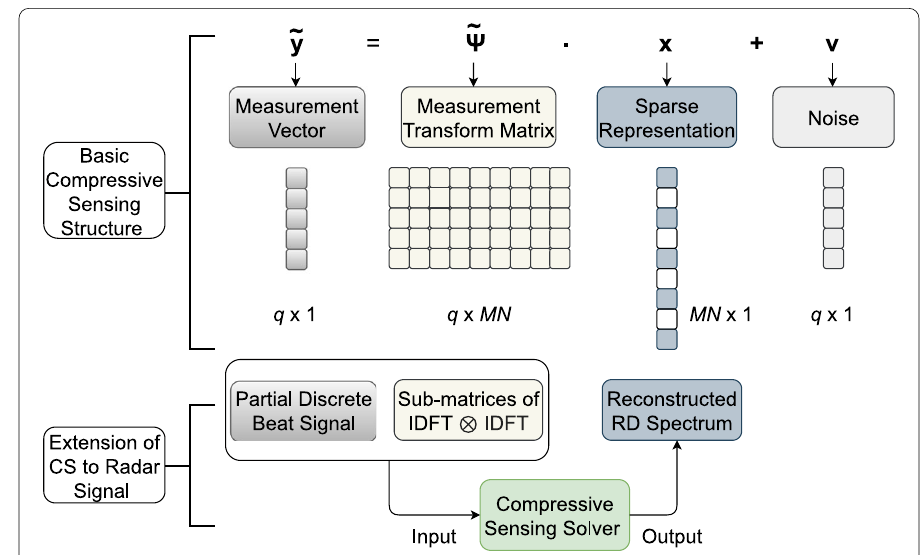
Fig. 2 Compressive sensing framework adopted to radar interference